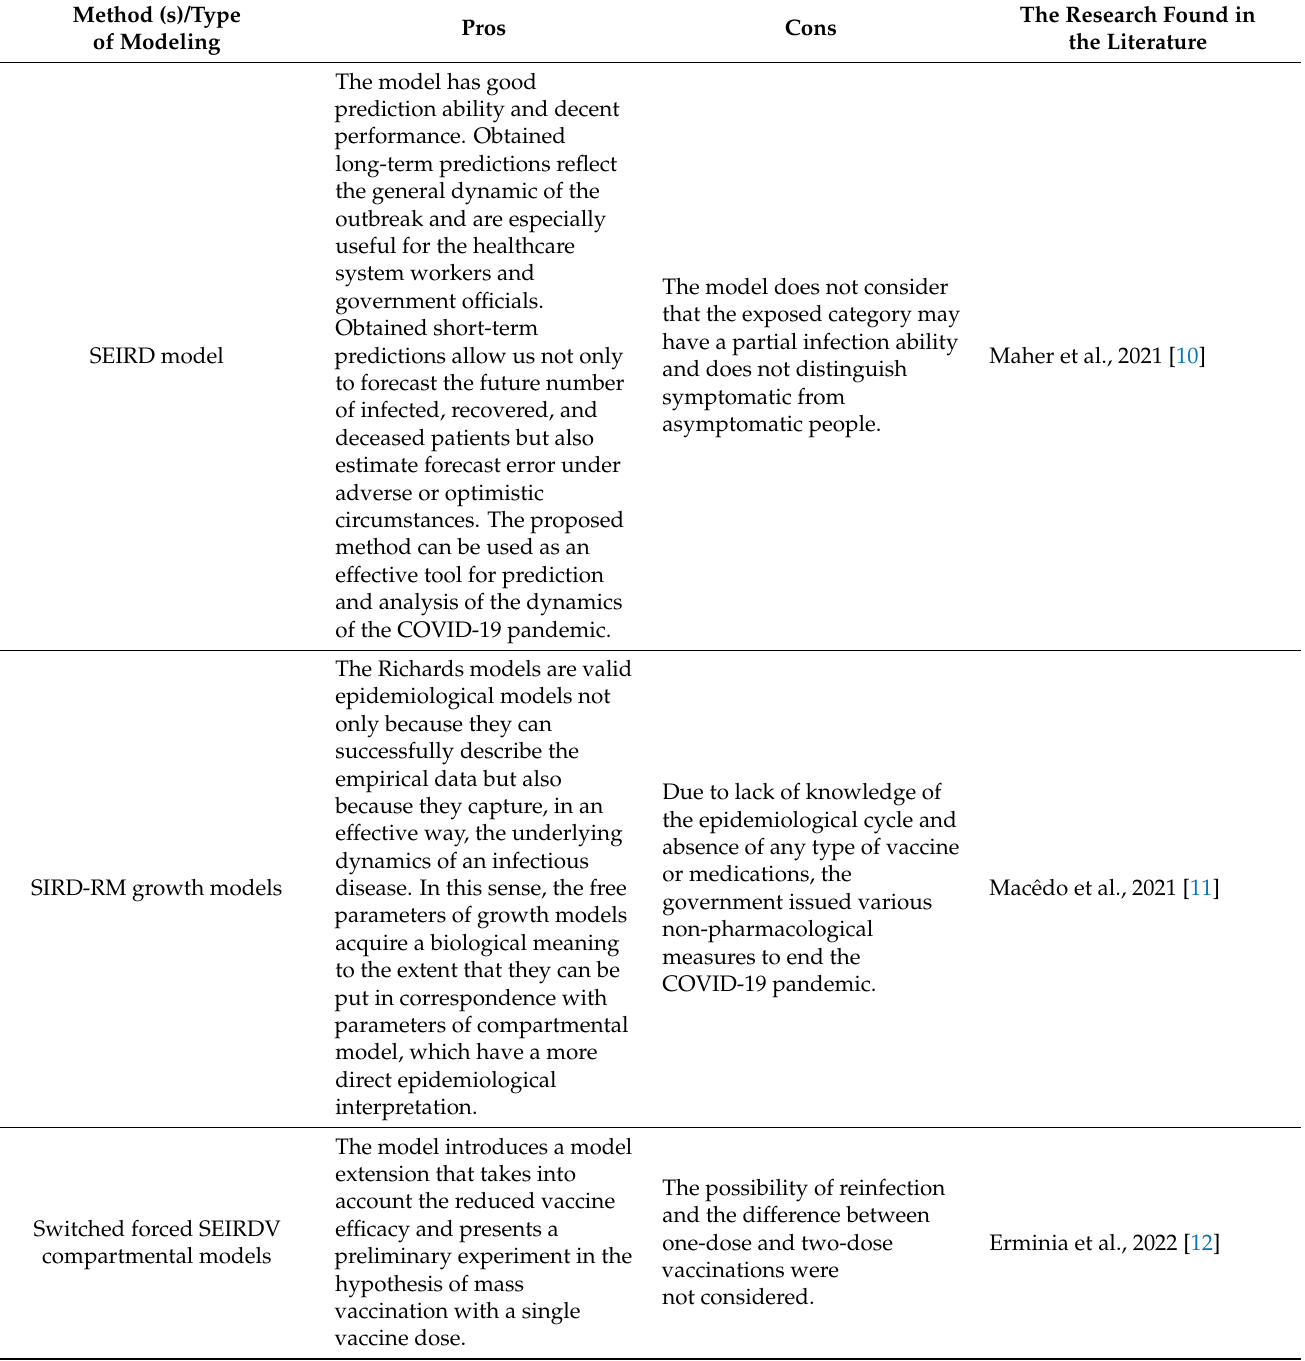
Table 1. Research work found in the literature for disease